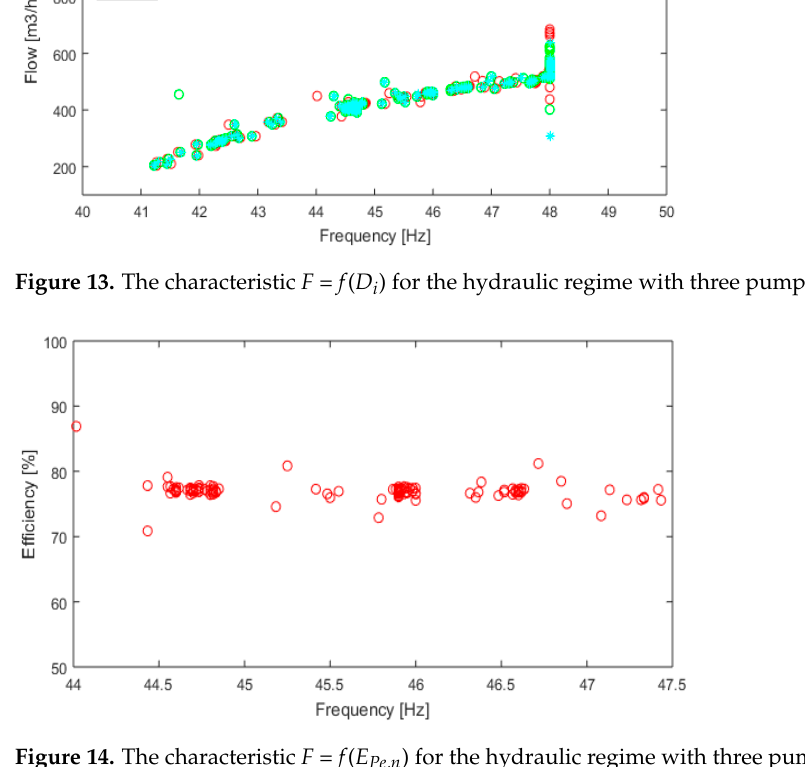
Figure 14. The characteristic F = f ( E Pe,n ) for the hydraulic regime with three pumps in operation.